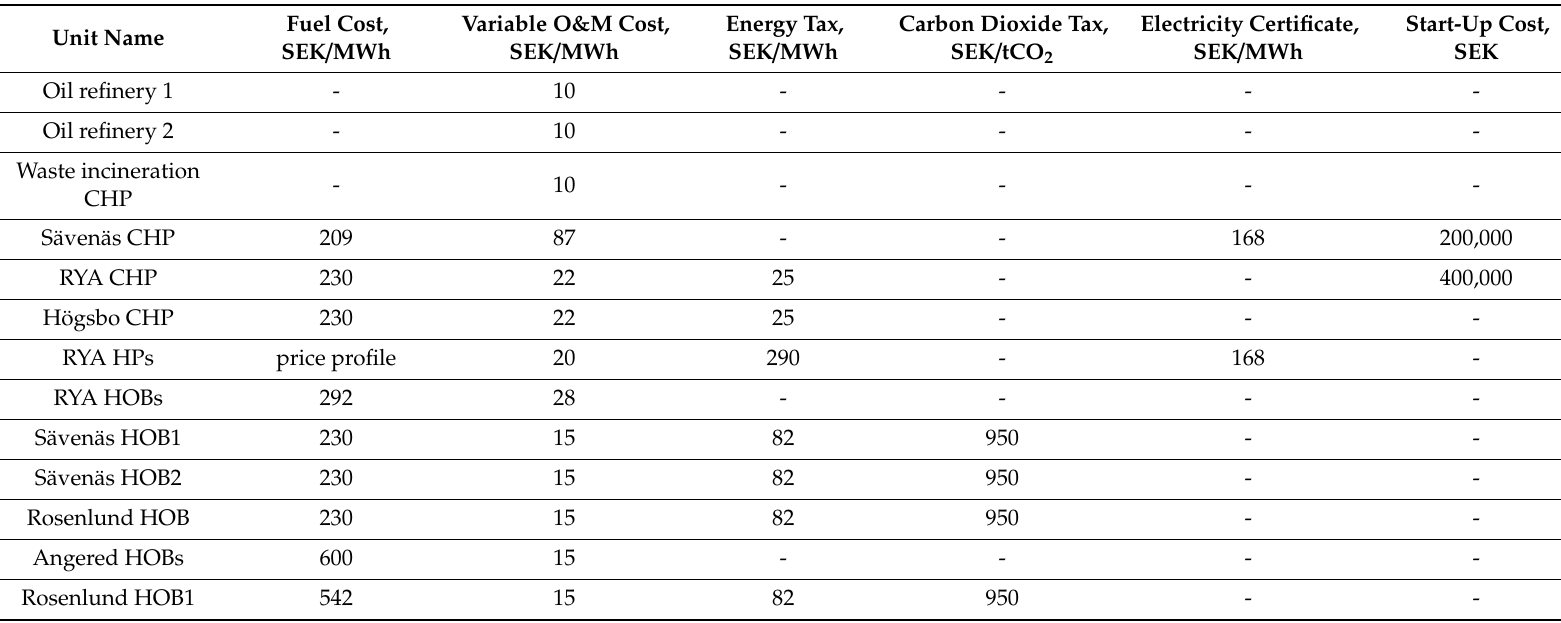
Table A2. Costs and taxes for the heat-only boilers (HOBs) and combined heat and power (CHP) generation units available in the district heating system of